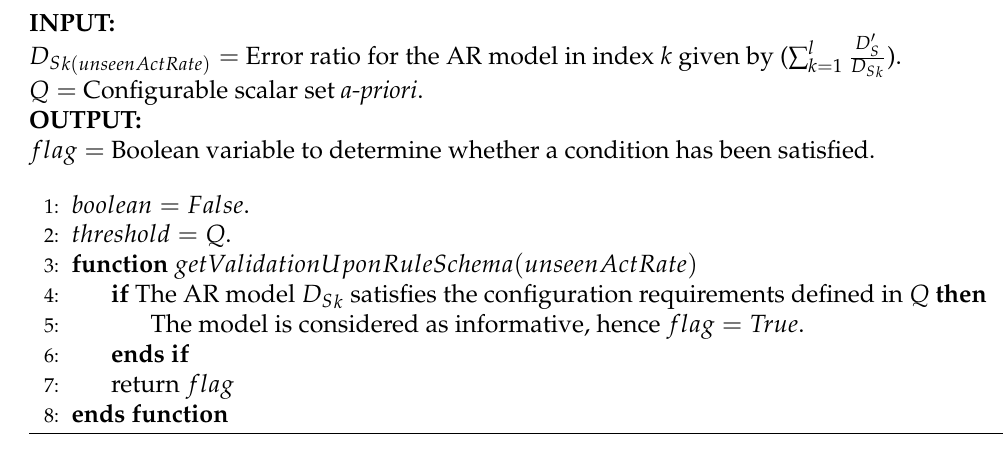
Algorithm 2 Validation of the AR model determined by accuracy